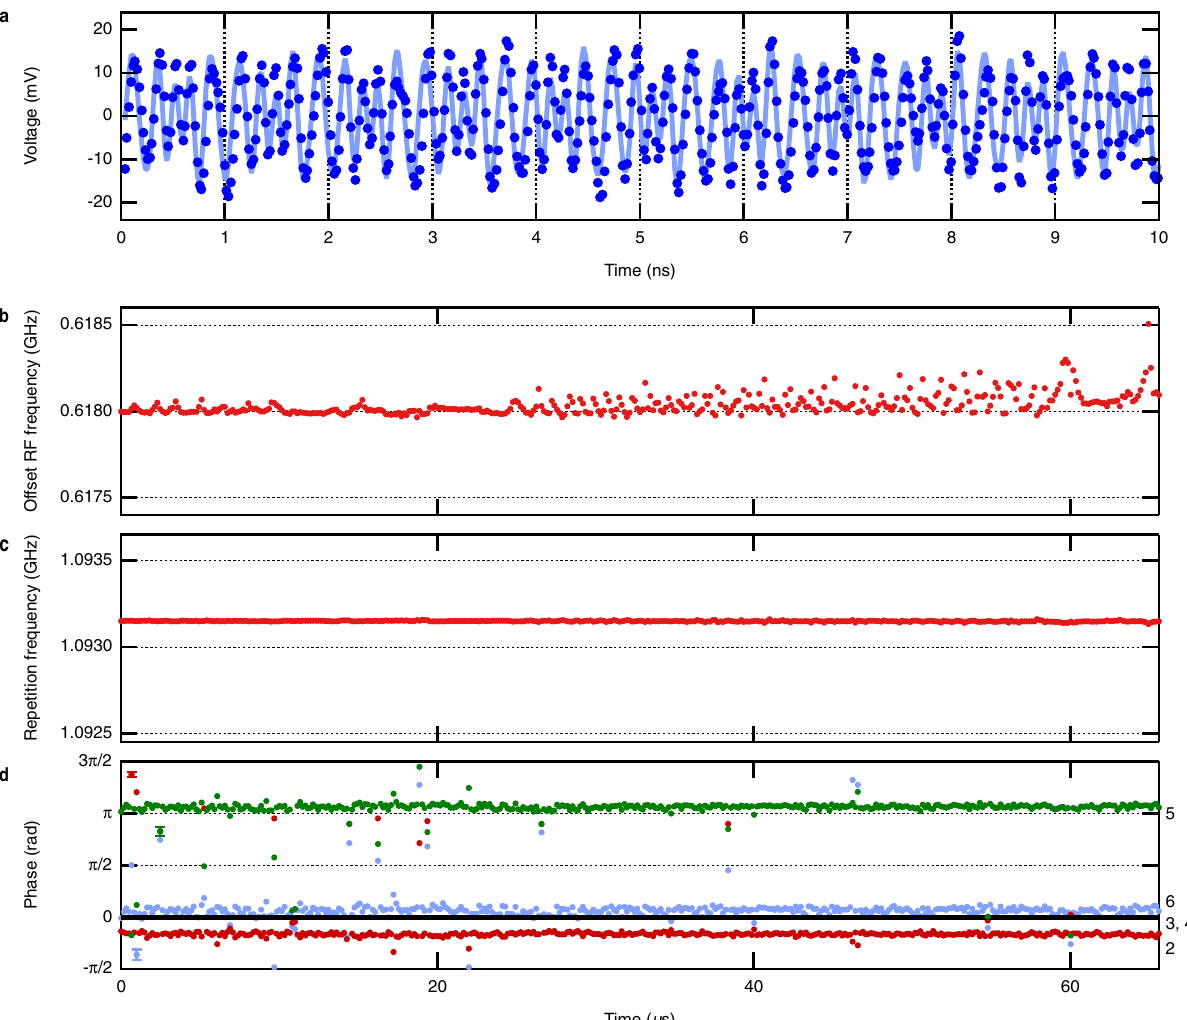
Fig. 2 Fixed relationship between modal phases. a Measured heterodyne temporal waveform of passive mode-locked state (dots) and fi tting curve (trace) plotted over 10 ns. The temporal resolution of the measurement was 20 ps. Long-term stability of b offset frequency, c repetition frequency, and d relative phase offsets over 65.6 µ s. The numbers beside the right axis show the mode indices corresponding to the markers. The error bars show the estimated standard deviation of the fi tting parameter. In panels b and c , the error bars are smaller than the marker size. In panel d , the error bars are shown in one data point in the fi rst few µ s for each marker as a typical short spans of 164 ns and fi tted the waveform in each short span.